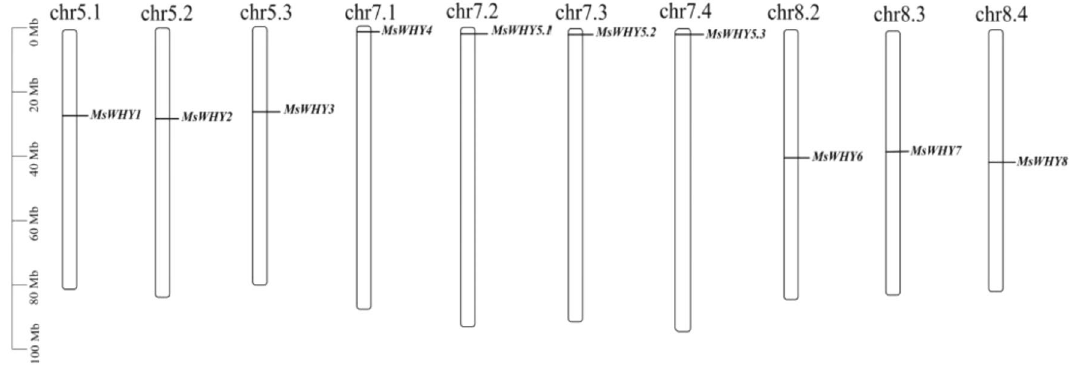
Figure 2. The distribution of MsWHY genes on 10 chromosomes in alfalfa. The scale (Mb) bar of the left displays the length of alfalfa chromosomes. The number of the chromosome is shown at the top of the